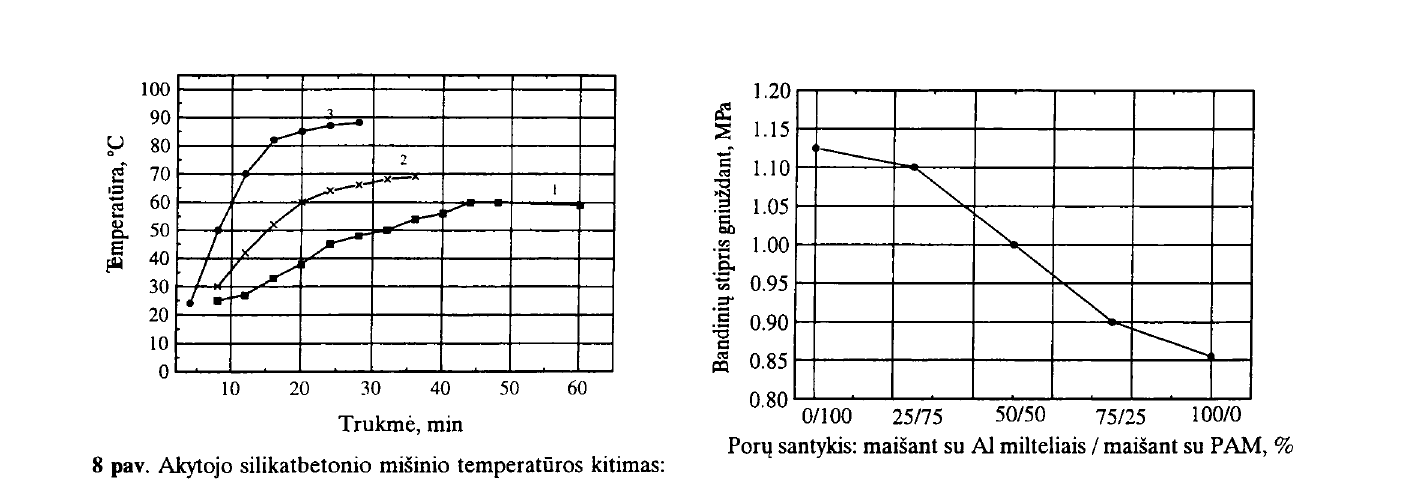
Fig 9. Porous silicate concrete (300 kg!m 3 ) compression strength dependency on structure formation method (po~es produced by mixing the mixture with AI powder and With SAM, ratio) 6. ISvados 1. Formuojant lietus (be aliuminio miteliq)